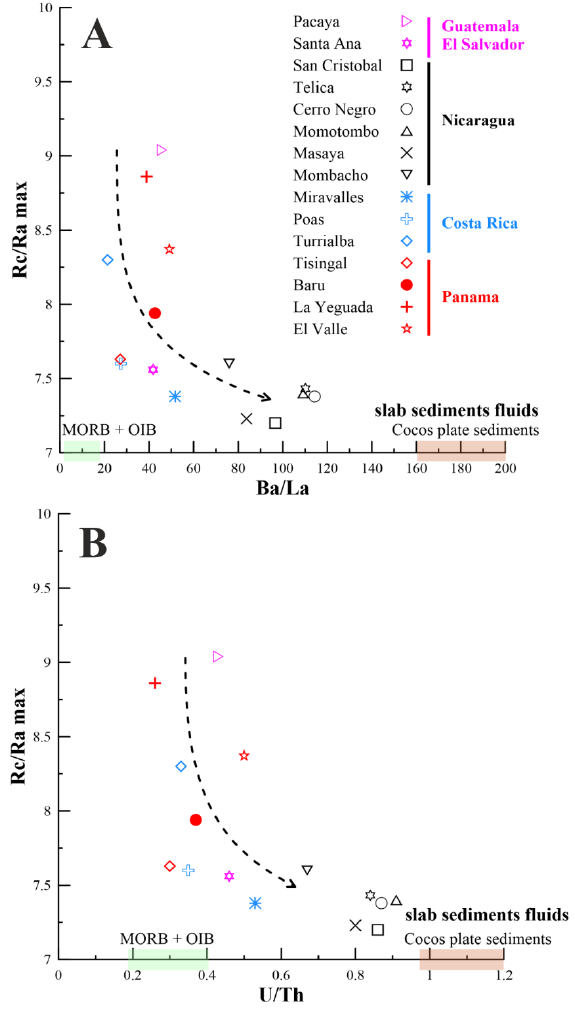
Figure 5. Ba/La ( A ) and U/Th ( B ) mean values (taken from GeoRoc pre-compiled files, considering only samples with SiO 2 < 60 wt.%; [125,126] versus the 3 He/ 4 He corrected for atmospheric contamination (Rc/Ra), for the selection of volcanoes from different segments of CAVA already mentioned in Figure 4 caption. Trace elements ratios for MORB, OIB and Cocos plate sediments are taken from